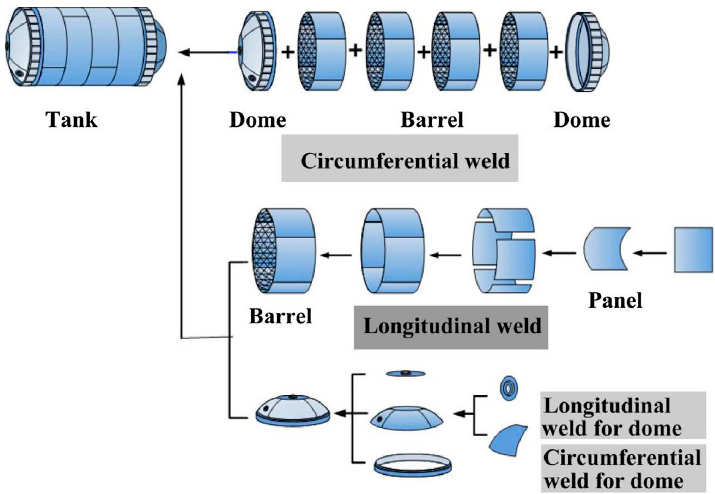
Figure 18. Schematic diagram for structure and main welds of launch vehicle tank [45] (has permis- sion from Elsevier).